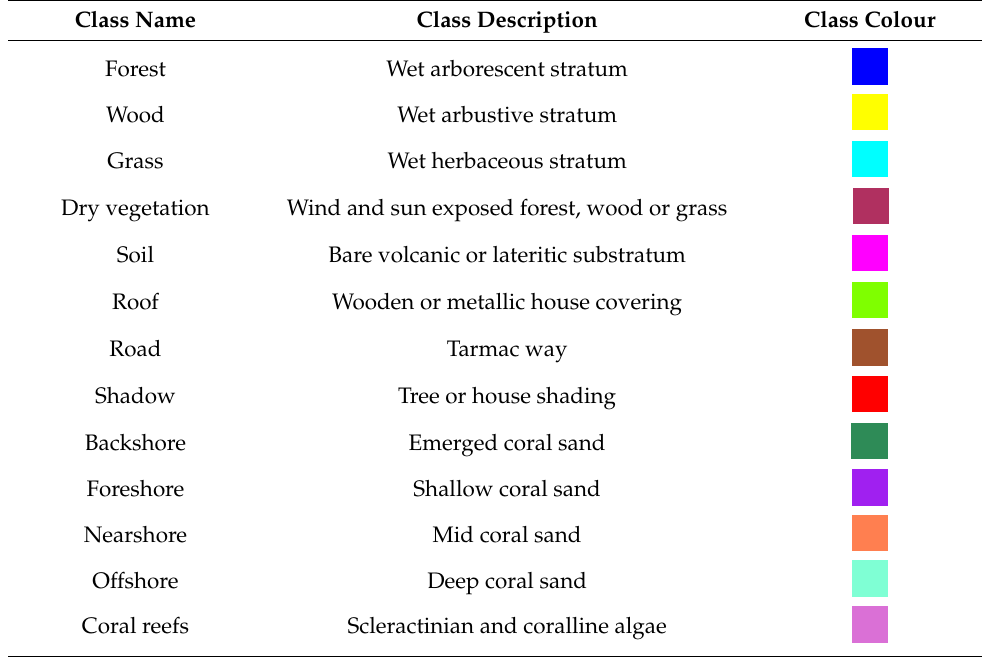
Table 1. Description of the 13 land use/land cover and sea use/sea cover classes. Class Name